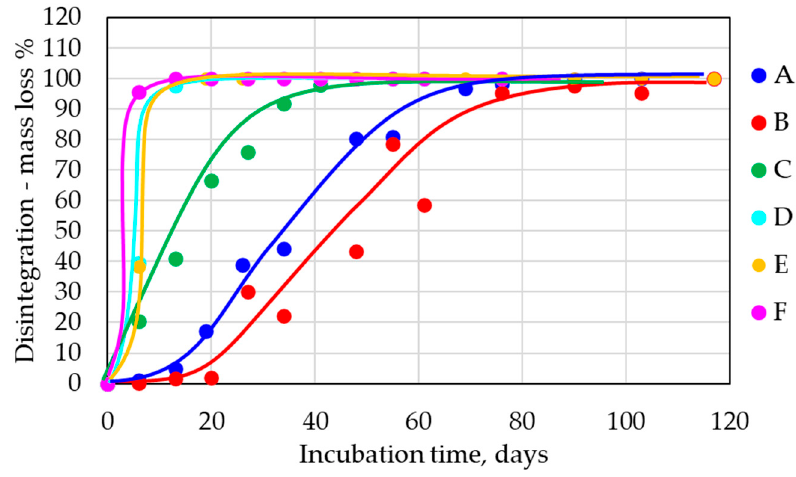
Figure 6. The disintegration of tested samples in a small electric composter, expressed as weight loss.